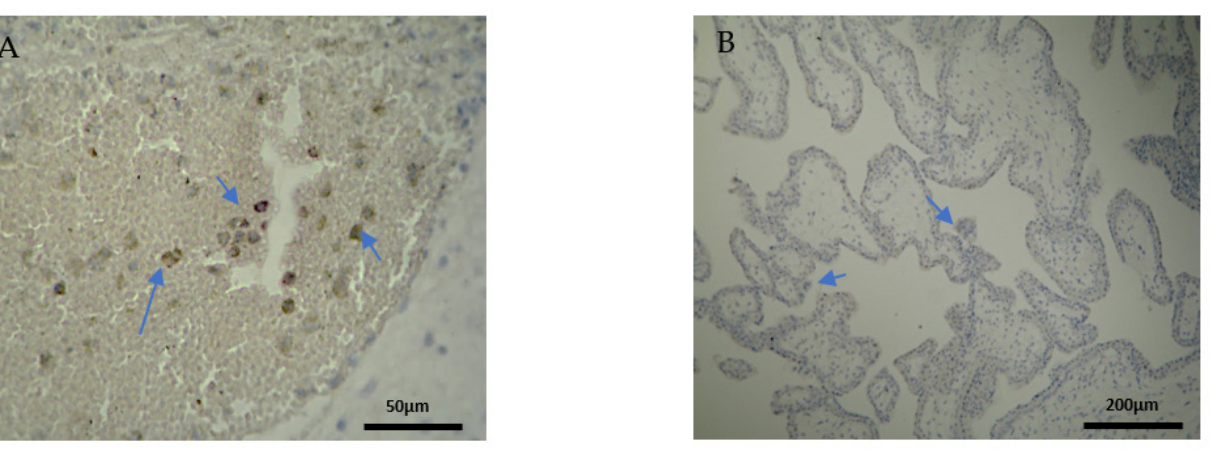
Figure 3 . Evaluation of positive CD4 antigen expression. Miscarriage Experimental Group (EG): ( A ) Moderate intensity of staining in the DB (4 × 40 magnification). ( B ) Low intensity of staining in the chorionic villi (4 × 10 magnification).